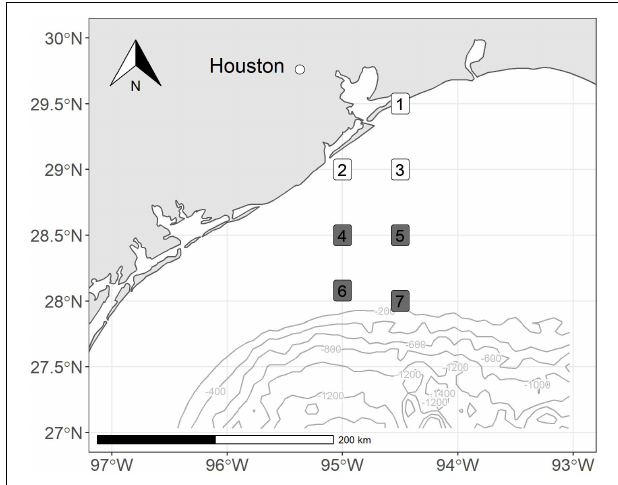
FIGURE 1 | Map of stations sampled off the coast of Texas, United States. Colors correspond to depth bin (nearshore = white, shelf =